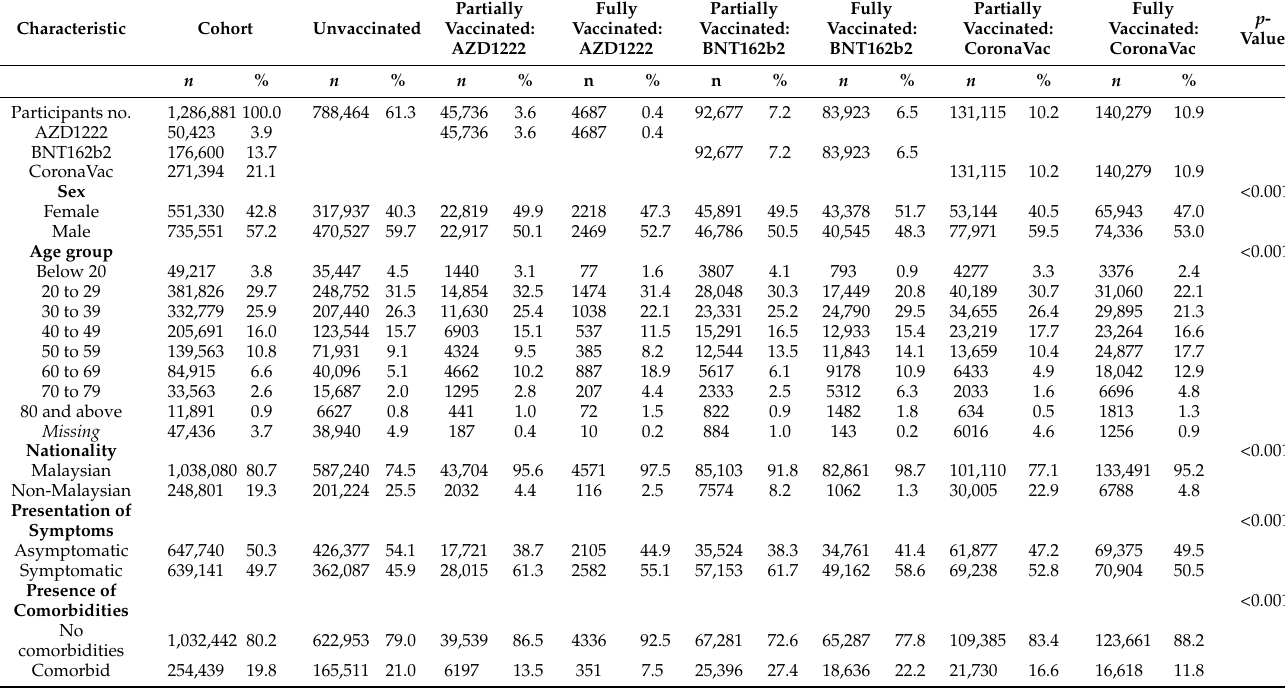
Table A1. Characteristics of the study cohort of confirmed COVID-19 cases, according to the type of vaccines and vaccination